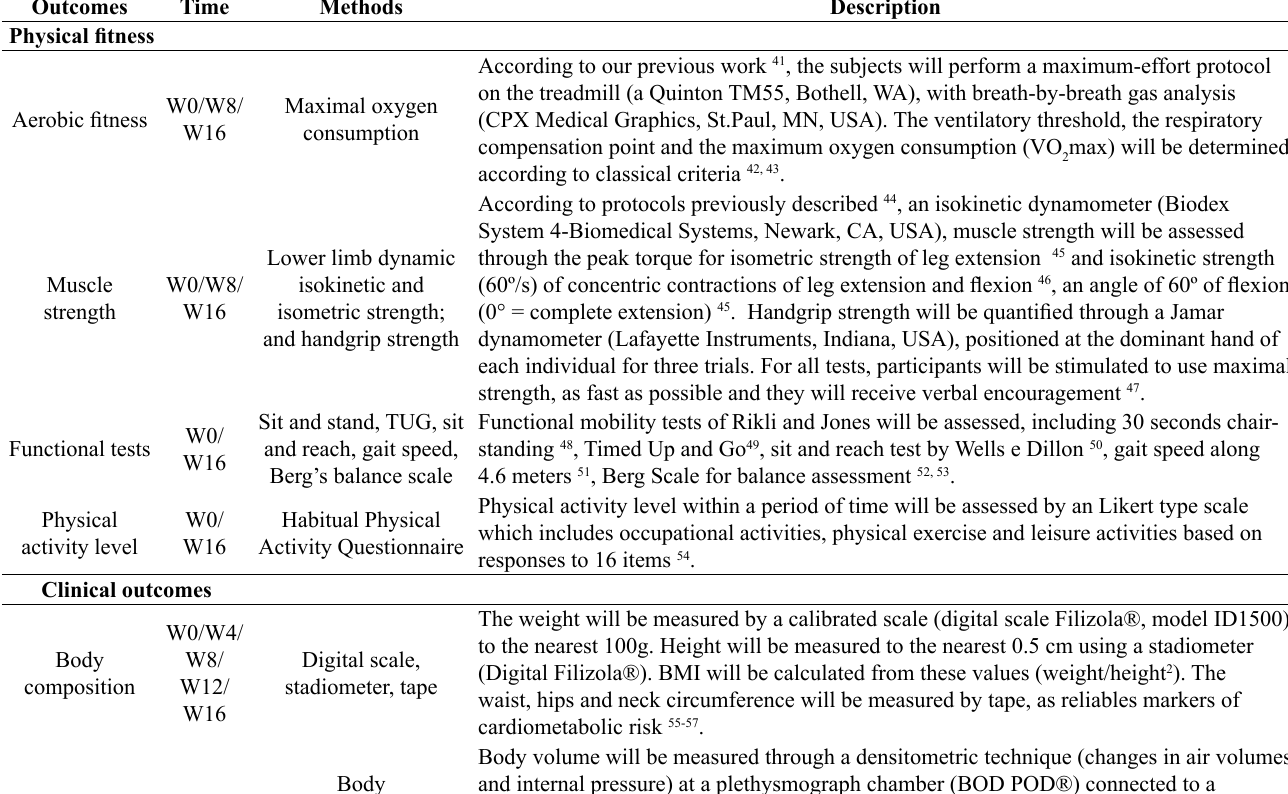
Table 1. Assessments